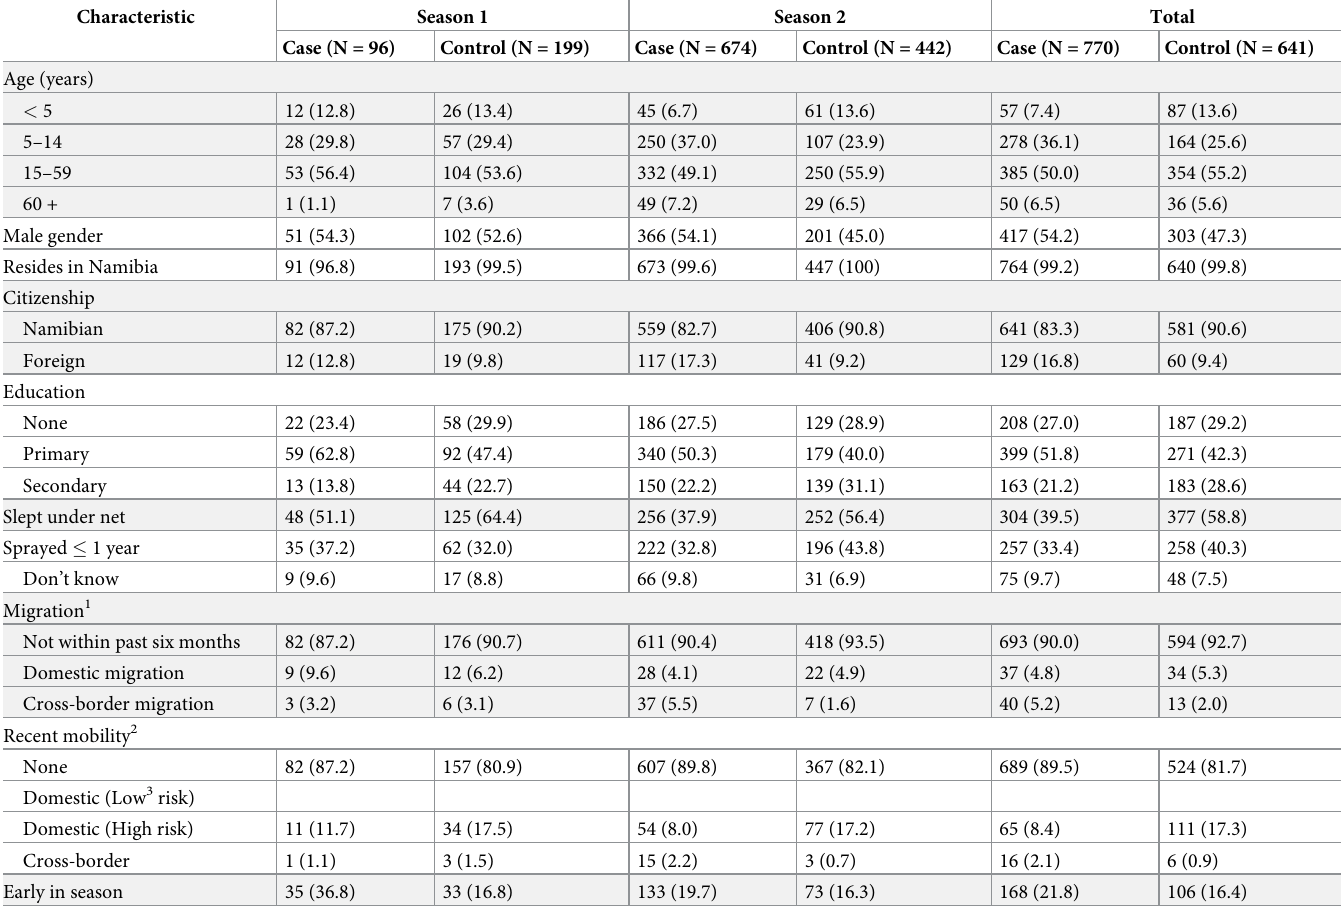
Table 1. Socio-demographics and select characteristics of 770 cases and 641 controls in Zambezi Region recruited between February 2015 and April 2016.